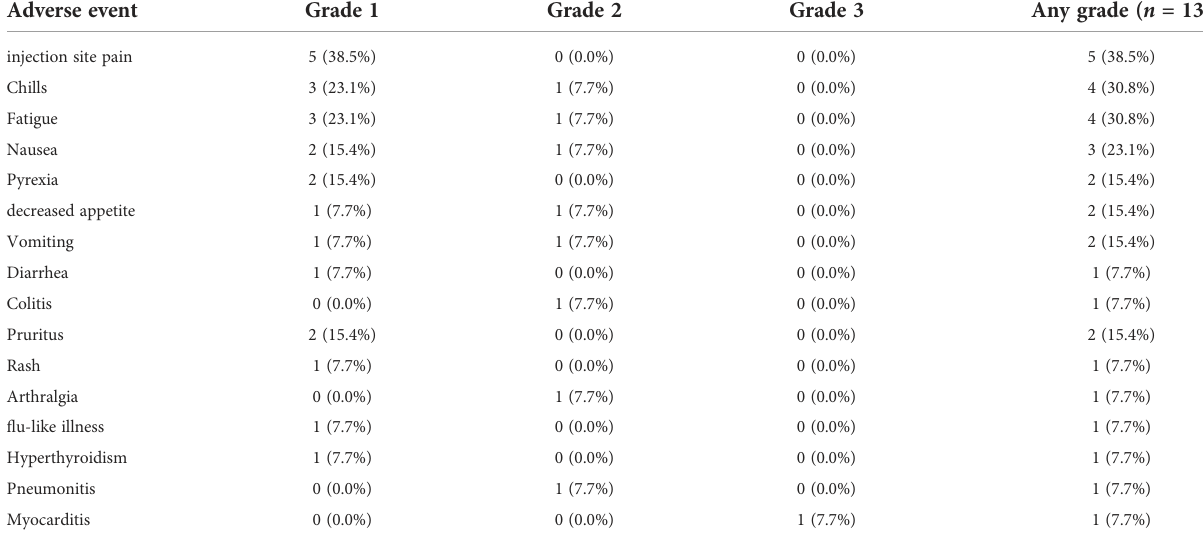
TABLE 2 Treatment-related toxicities in phase